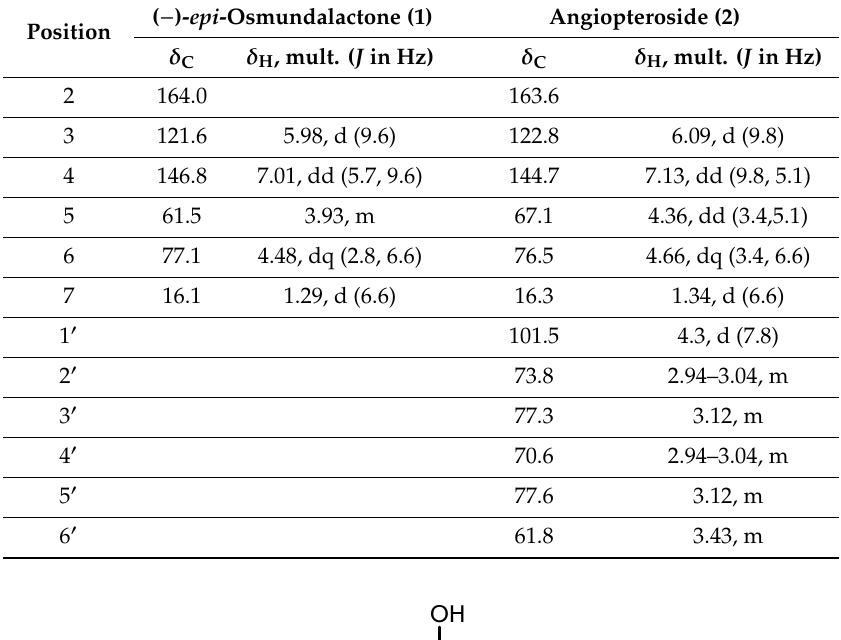
Table 1. 1 H and 13 C NMR data of compound 1 and 2 in DMSO- d 6.